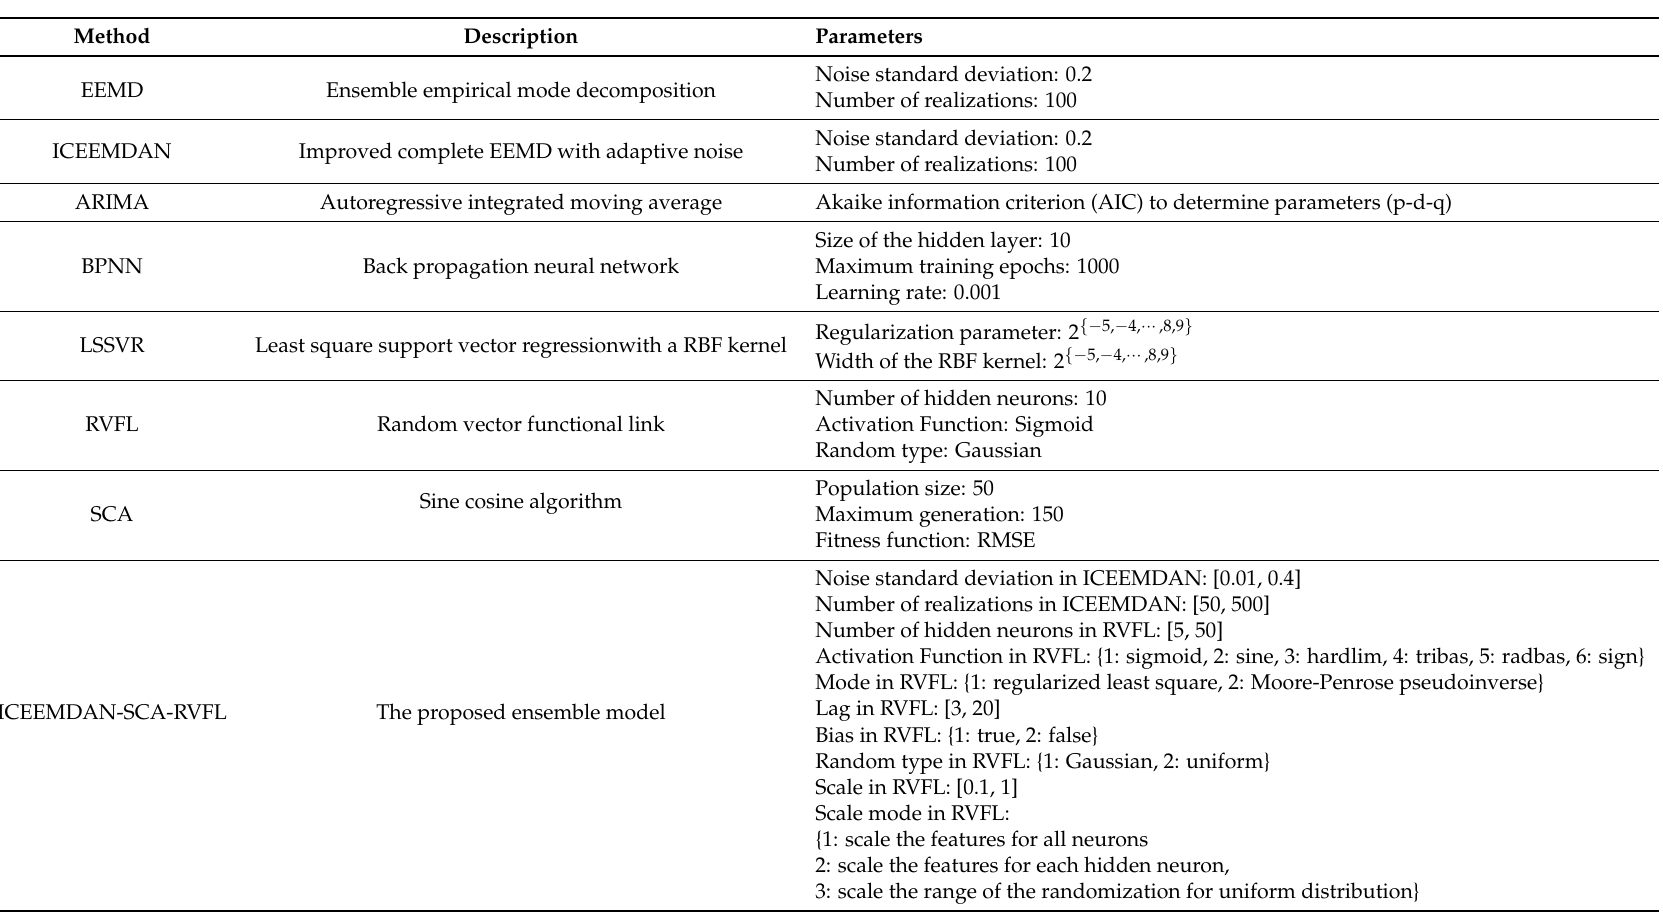
Table 1. Parameter